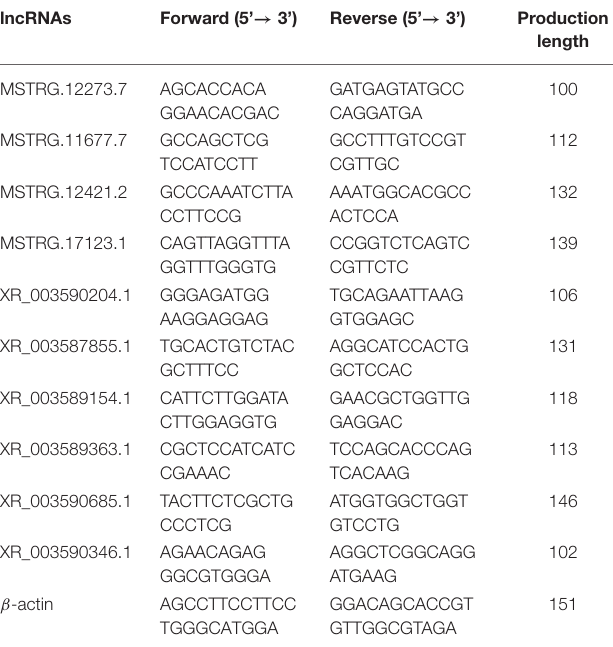
TABLE 1 | A list of primers used for real-time quantitative PCR (RT-qPCR). lncRNAs